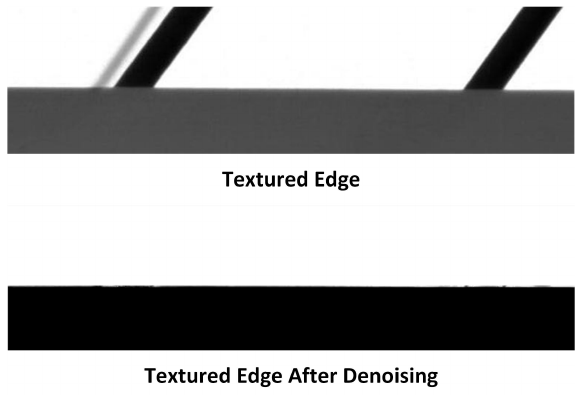
Figure 9. Selected textured edge and edge after colorization